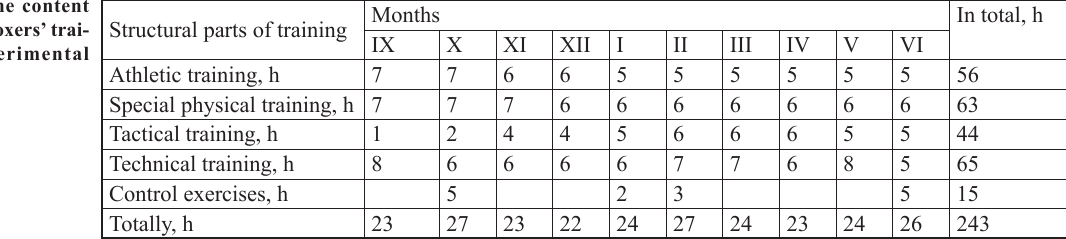
Table 1. The content of young boxers’ trai- ning (experimental